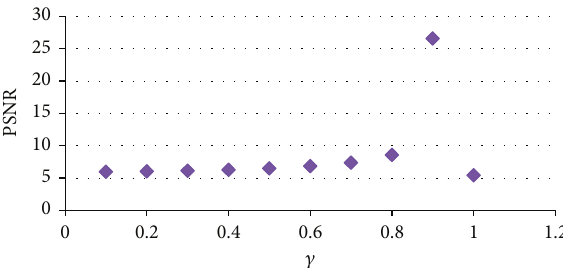
Figure 3: Choice of fractional 𝛾 at 𝛼 = 0.5 , for “Boat” corrupted by Gaussian noise with 𝜎 = 25 .